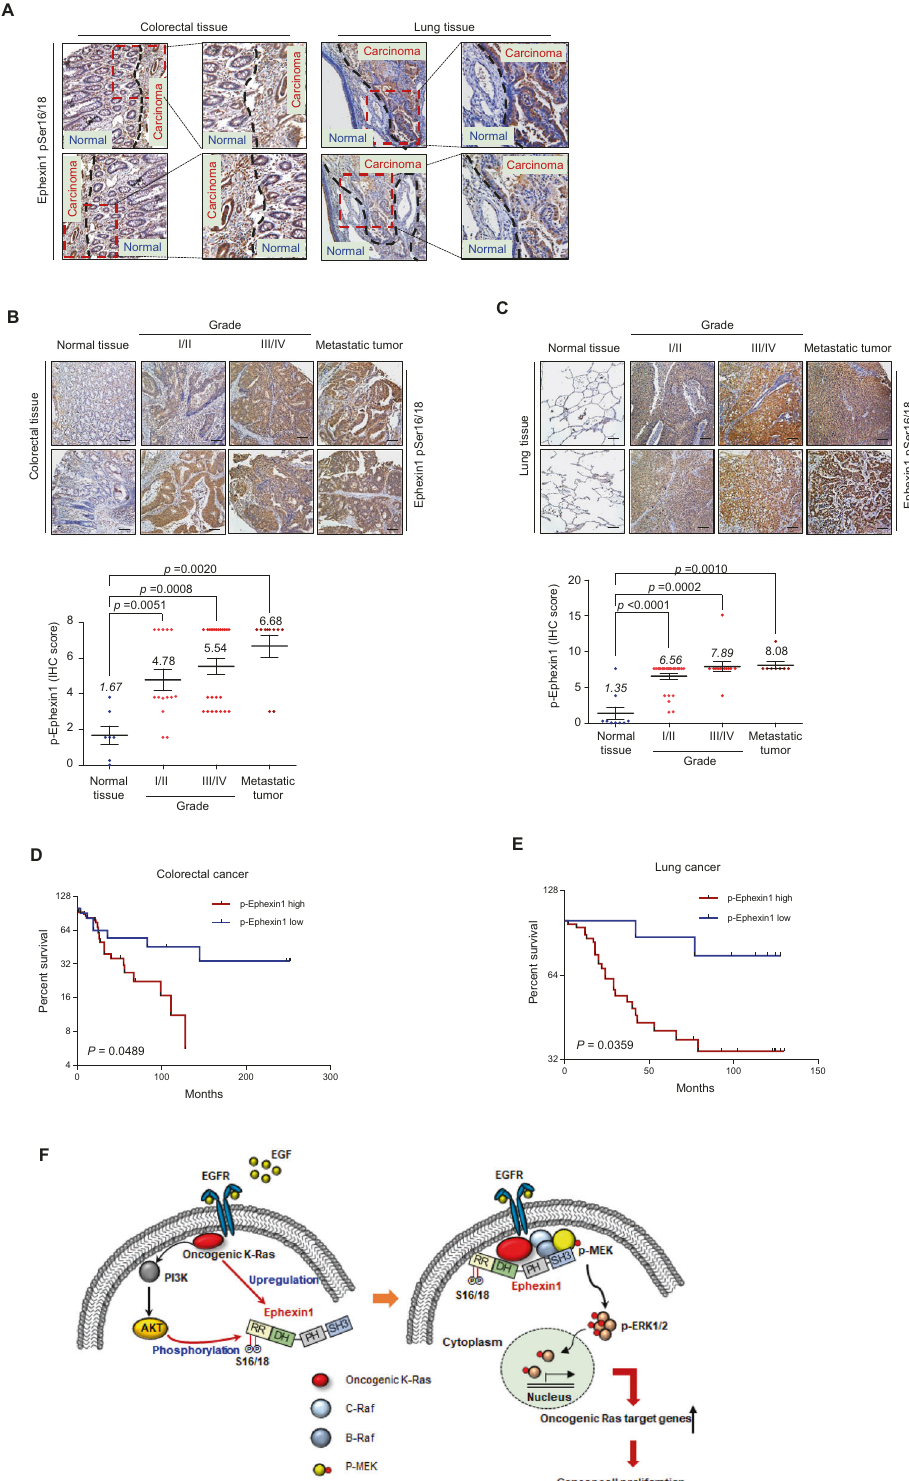
tumor growth in vivo. Expression levels of pS16/S18 Ephexin1 were associated with increasingly malignant grades of CRC and LC and metastatic cancer, and high pS16/S18 Ephexin1 expression correlated with poor prognosis in CRC and LC patients. Ephexin1 promotes Rho GTPase activity, which is a known component